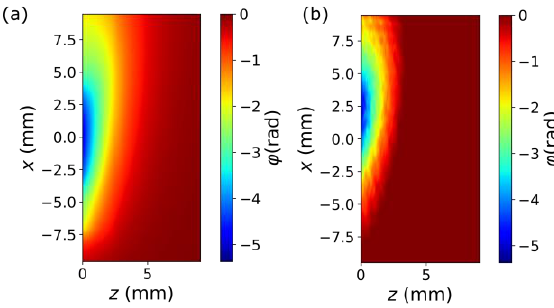
Fig. 3. Numerical (a) and experimental (b) calculated phase shift for a probe beam propagating along 𝐞 𝑦